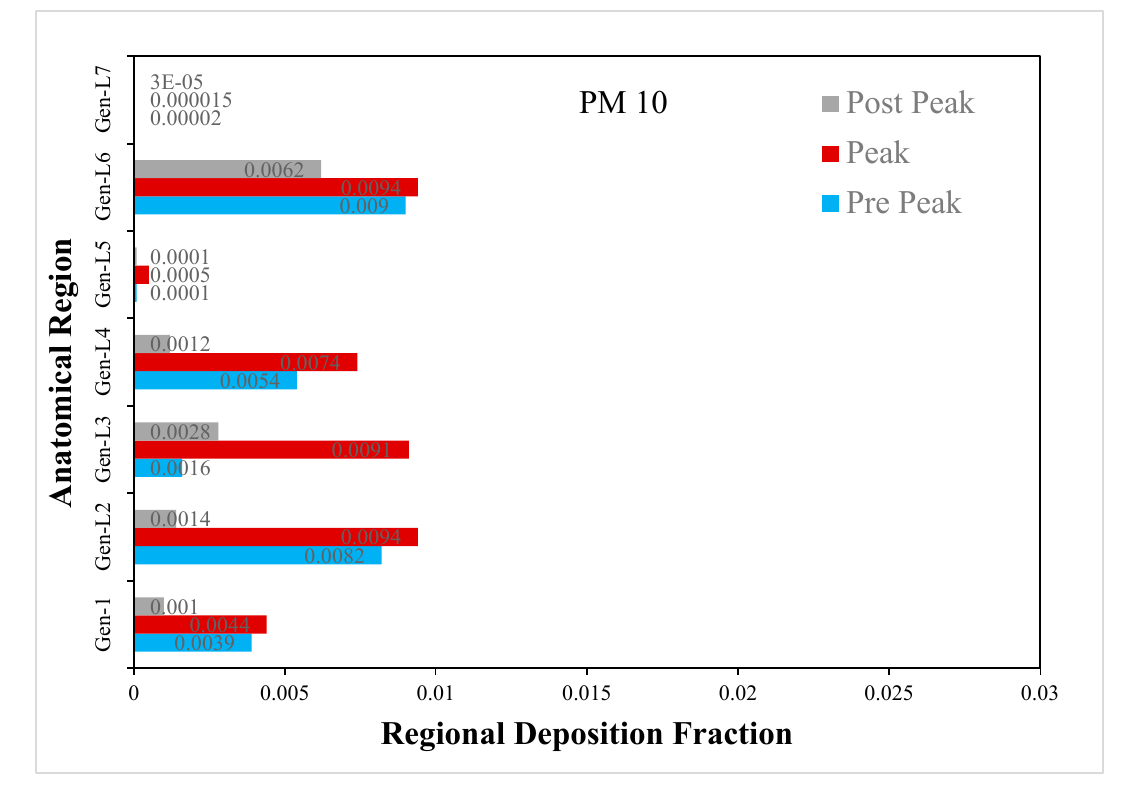
Figure 10. ( a ) Regional deposition fraction (RDF) of PM 10 during normal inspiration, ( b ) Regional deposition fraction (RDF) of PM 10 during moderate inspiration.